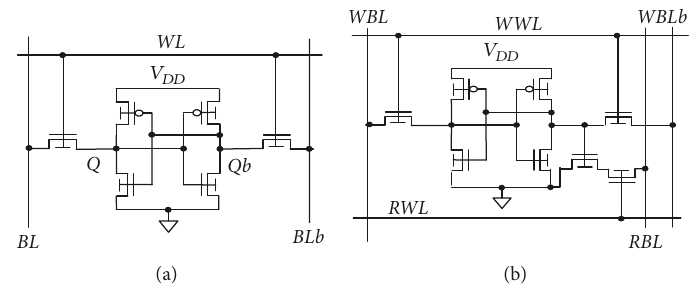
Figure 7: Reproduced from H. Yang et al. (2017) (under the Creative Commons Attribution License/public domain).